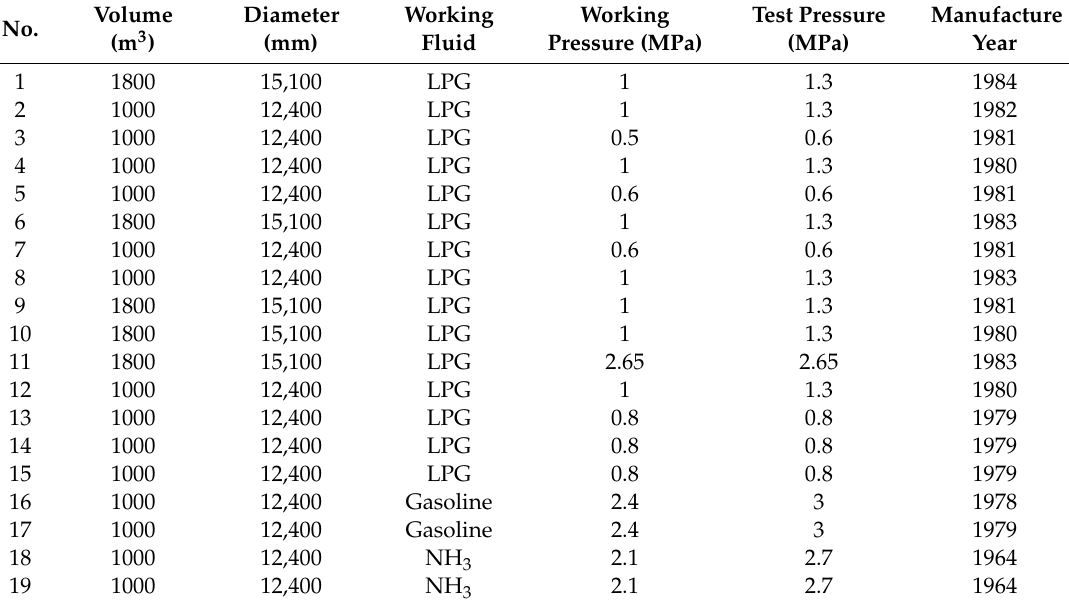
Table 1. Main features of the spheres that were investigated in this study. LPG: liquid petroleum gas. No.